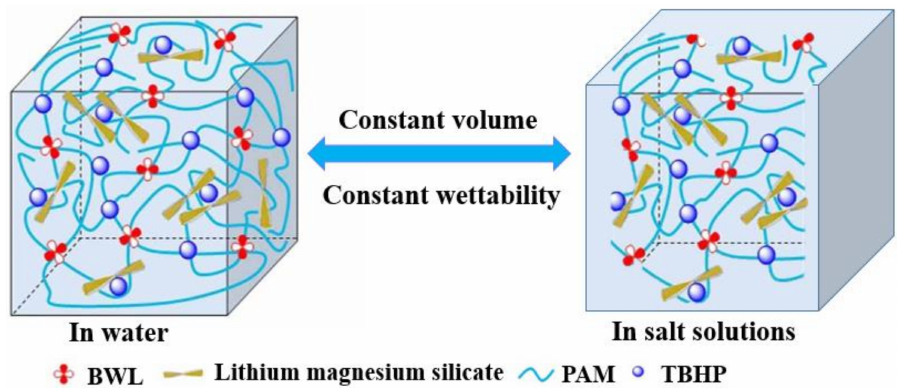
Figure 16. Schematic diagram of partial structural collapse of shear thixotropic polymer